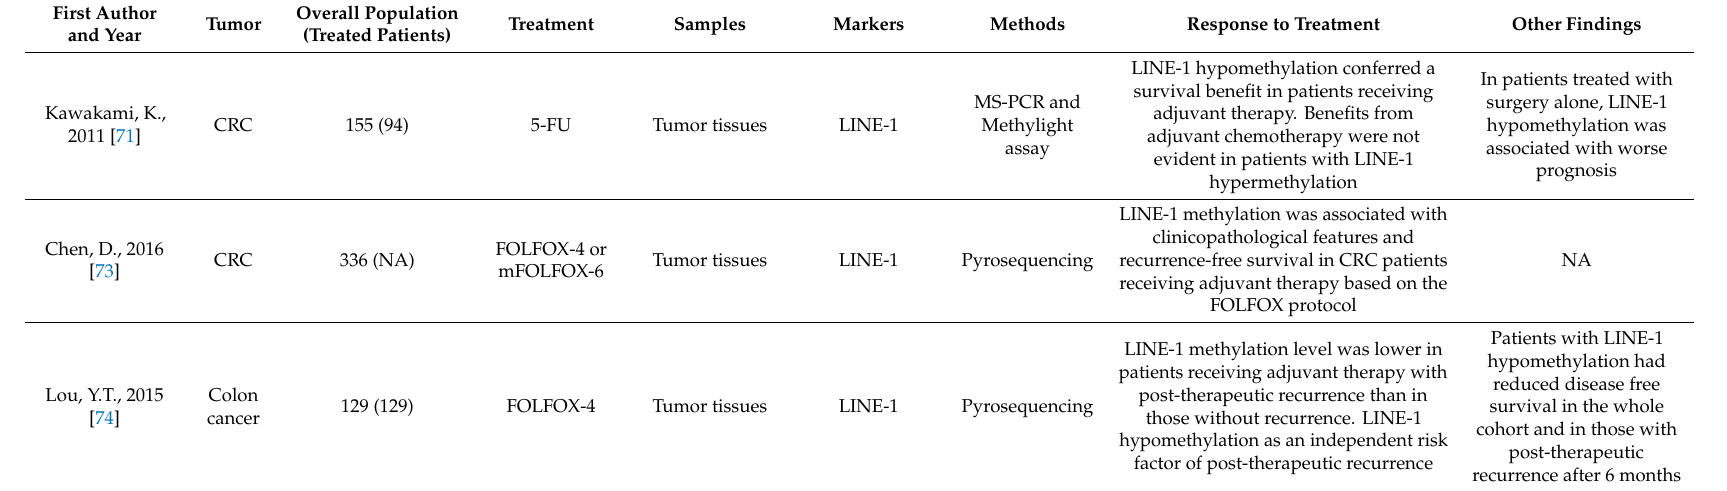
Table 3. LINE-1 methylation markers in patients receiving adjuvant